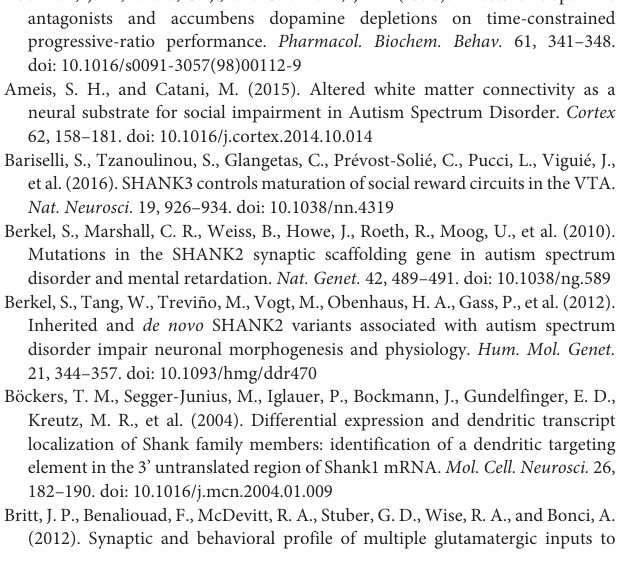
FIGURE S2 | Lack of change in synaptic protein expression in Shank2 KO rat. Neither the HP (A) nor the striatum (B) show significant changes in synaptic protein expression unlike in the Shank2 mutnat mouse. Values are expressed as fold change relative to the average WT value. Bars indicate SEM.